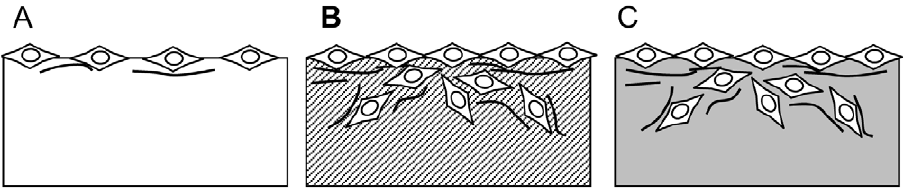
Figure 6. Schematic illustration of the results. A) Periodontal ligament fibroblasts on the peptide scaffold RADA16, B) on the functionalized peptide scaffold PRG and C) on the functionalized peptide scaffold PDS. In case of the functionalized peptide scaffold PRG and PDS, periodontal ligament fibroblasts showed cell proliferation, migration into the scaffolds and type I and type III collagen productions required to regenerate periodontal ligament.